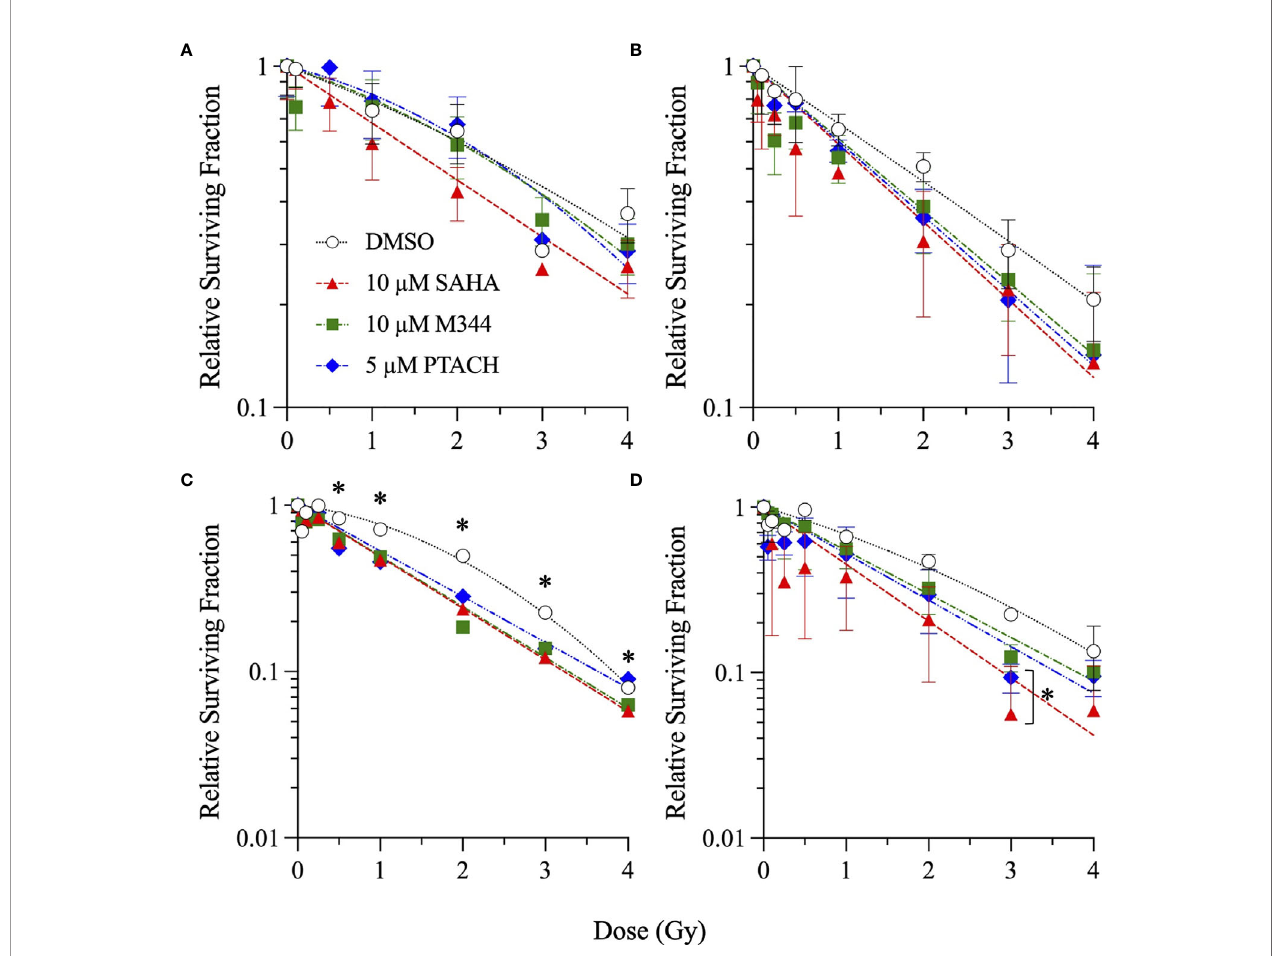
FIGURE 9 | Clonogenic survival of asynchronously growing normal NFF28 primary fi broblasts pretreated for 18 h with 10 µM SAHA, 10 µM M344, and 5 µM PTACH and irradiated cesium-137 g -rays (A) , 200 MeV protons (B) , 290 MeV/n C-12 ions (C) , or 350 MeV/n O-16 ions (D) . Data reported as mean ± SD; where error bars are not visible, they are smaller than the data point. Unlike the radioprotection observed following HDACi pretreatment in G0/G1-phase cultures irradiated with C-12 or O-16 ions, 18 h HDACi pretreatment of asynchronously growing NFF28 fi broblast cultures resulted in radiosensitization. Asterisks mark signi fi cant differences compared to DMSO controls at p -values of ≤ 0.05 (*) by one-way